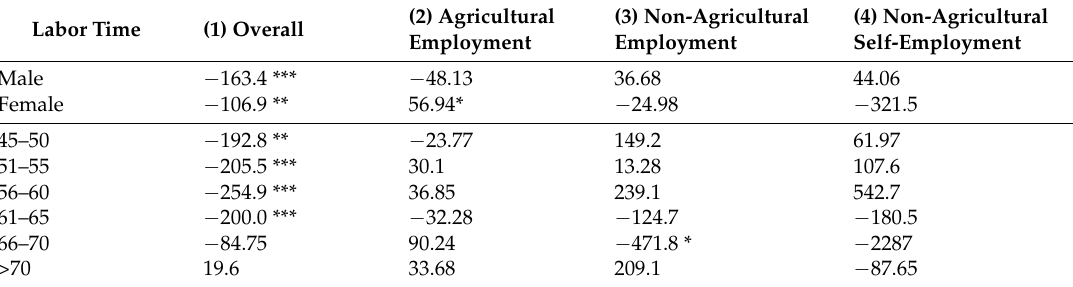
Table 5. The gender and age differences of health impaction of labor